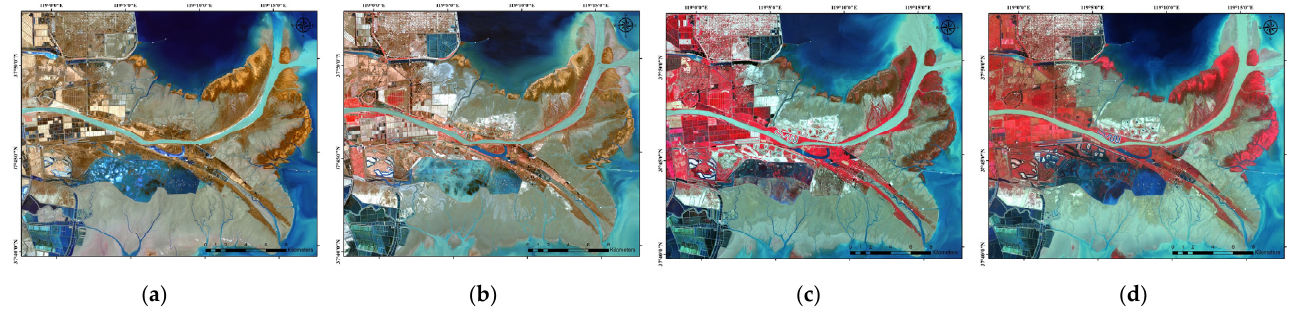
Figure 7. Images for Multi-season Random Forest classification. ( a ) 1 February 2019. ( b ) 2 May 2019. ( c ) 1 July 2019. ( d ) 8 November 2019.